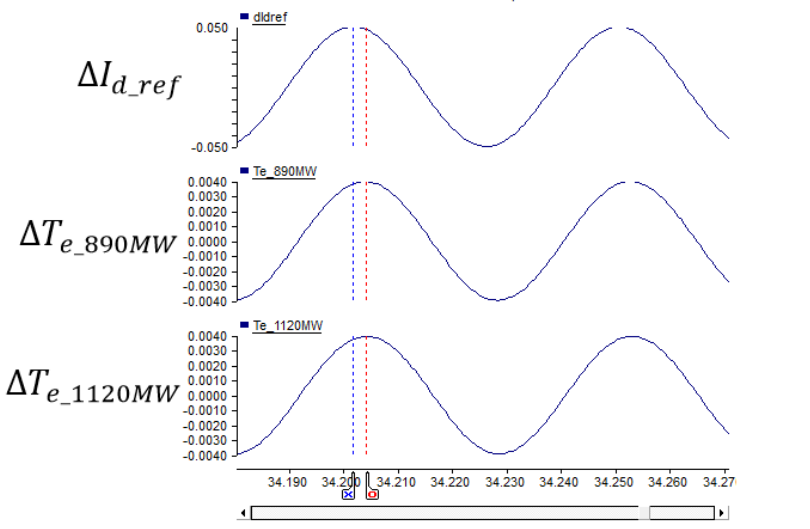
, and the corresponding electrical torques, ∆𝑇 d_ref